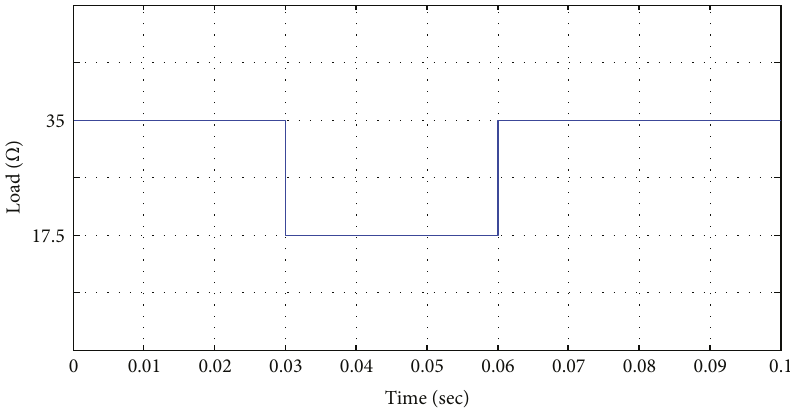
Figure 18: Load variation